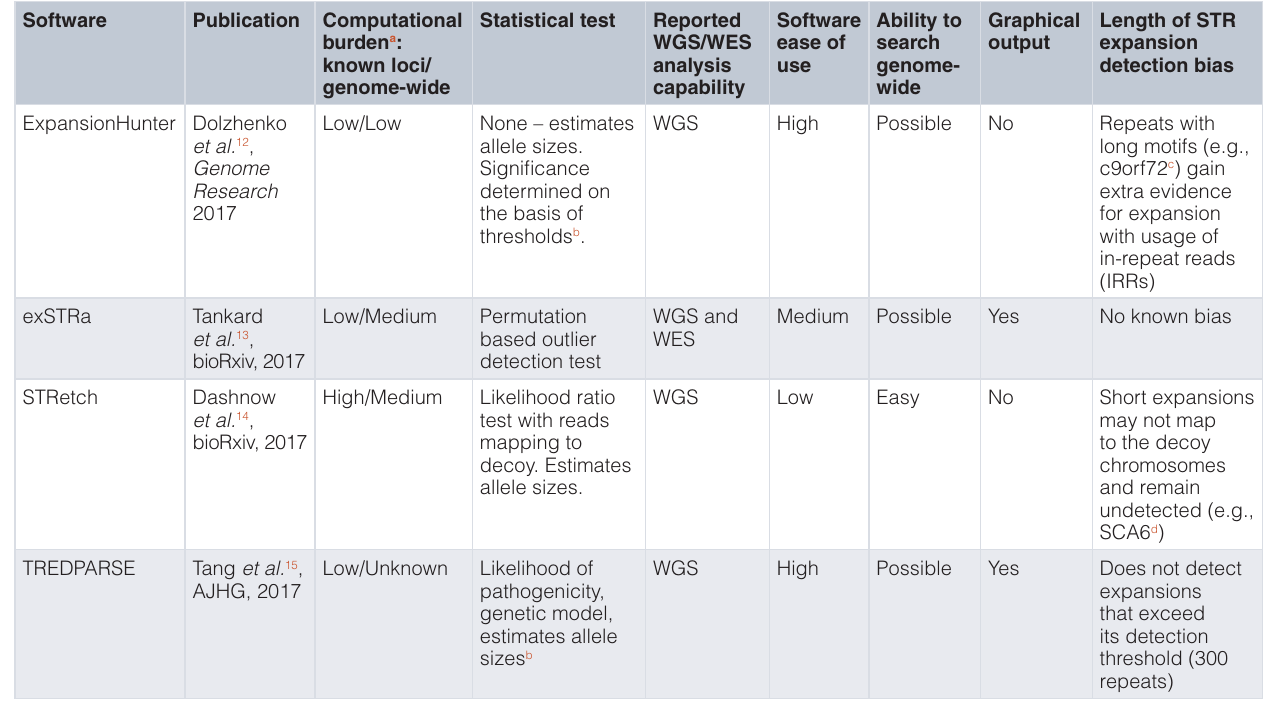
Table 2. Summary of computational methods, evaluation framework, and limitations for ExpansionHunter, exSTRa, STRetch, and